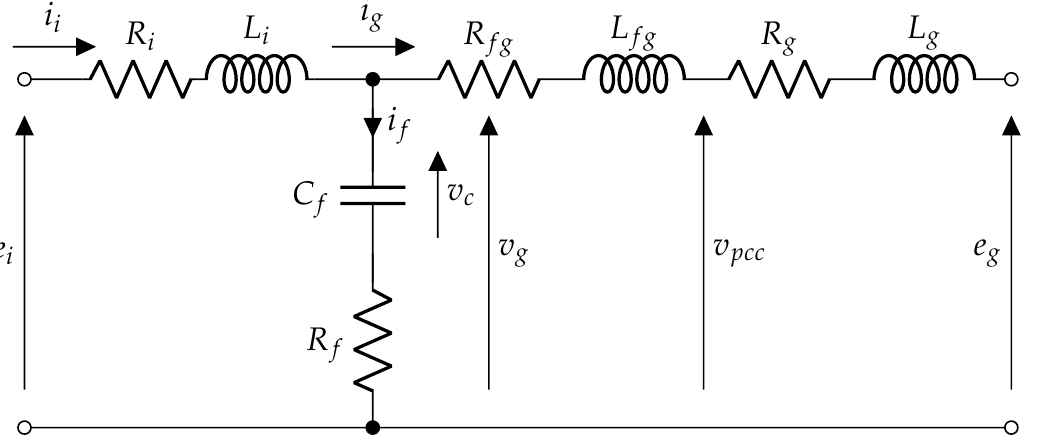
ϕ g Eg ω r Ref. Calculation Figure 4. Block diagram of the modeled S-VSC [23] control with the physical system. 4.3. Dynamic Components Definition 4.3.1. LCL Filter